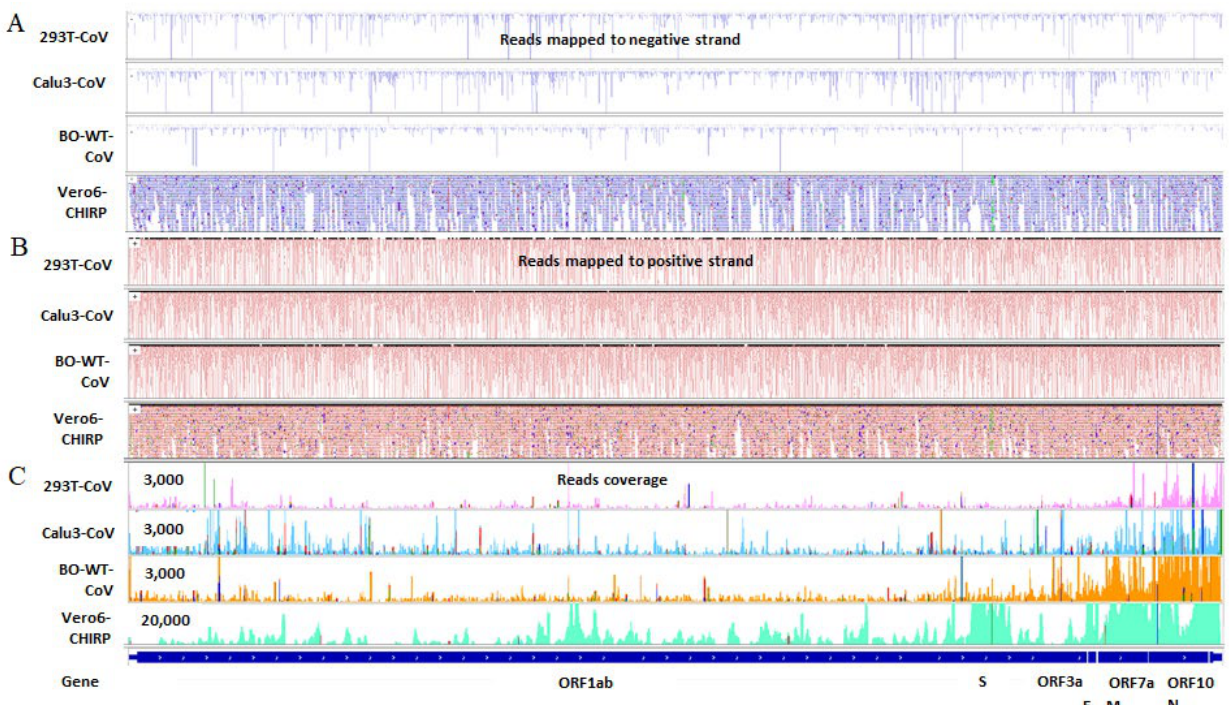
Figure 3. Comparative IGV view of reads from smRNAseq datasets of HEK293T-hACE2, Calu3-CoV (Calu3-EW), BO-WT-CoV, and ChIRP data from Vero-E6 cells mapped to the SARS-CoV-2 genome. ( A ) Reads mapped to the full-length negative genome of SARS-CoV-2; ( B ) reads mapped to the full-length positive genome of SARS-CoV-2; ( C ) read coverage on full-length SARS-CoV-2 genome. Refer to Table 1 for detailed information on infection and abbreviations of samples.